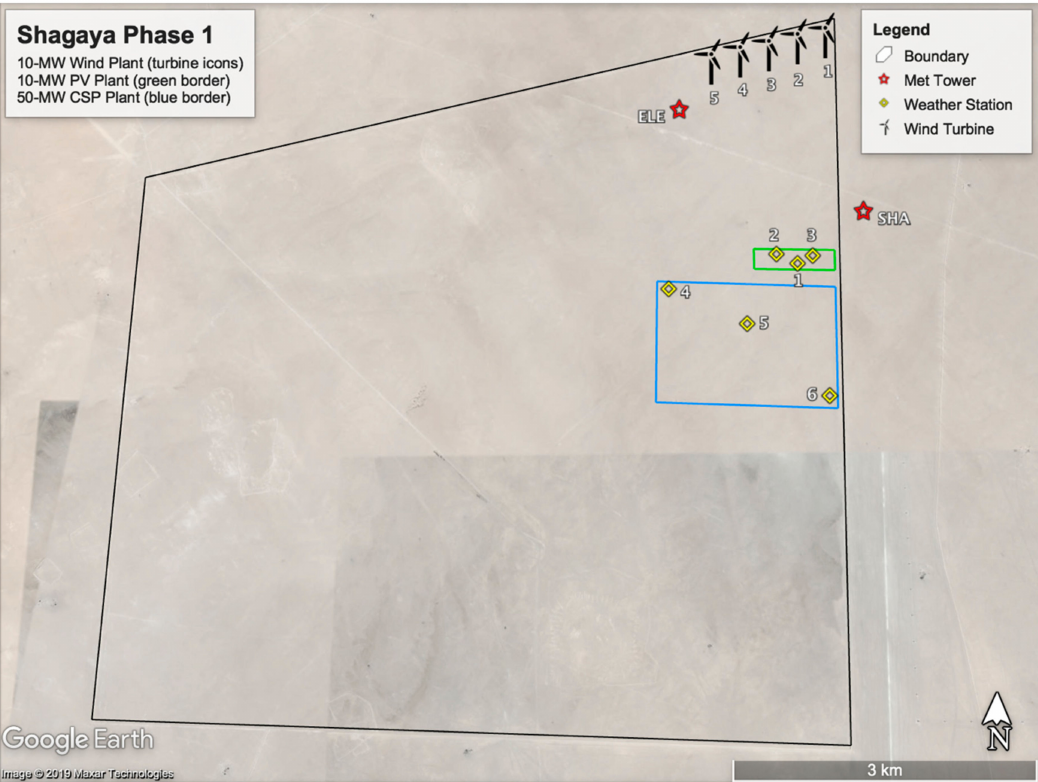
Figure 2. Map of Shagaya Renewable Energy Park Phase 1 installations, with Phase 1 & 2 boundary fence (black polygon), 10-MW wind plant (turbine icons), 10-MW PV plant (green rectangle), 50-MW CSP plant (blue rectangle), weather stations (yellow diamonds), and met towers (red